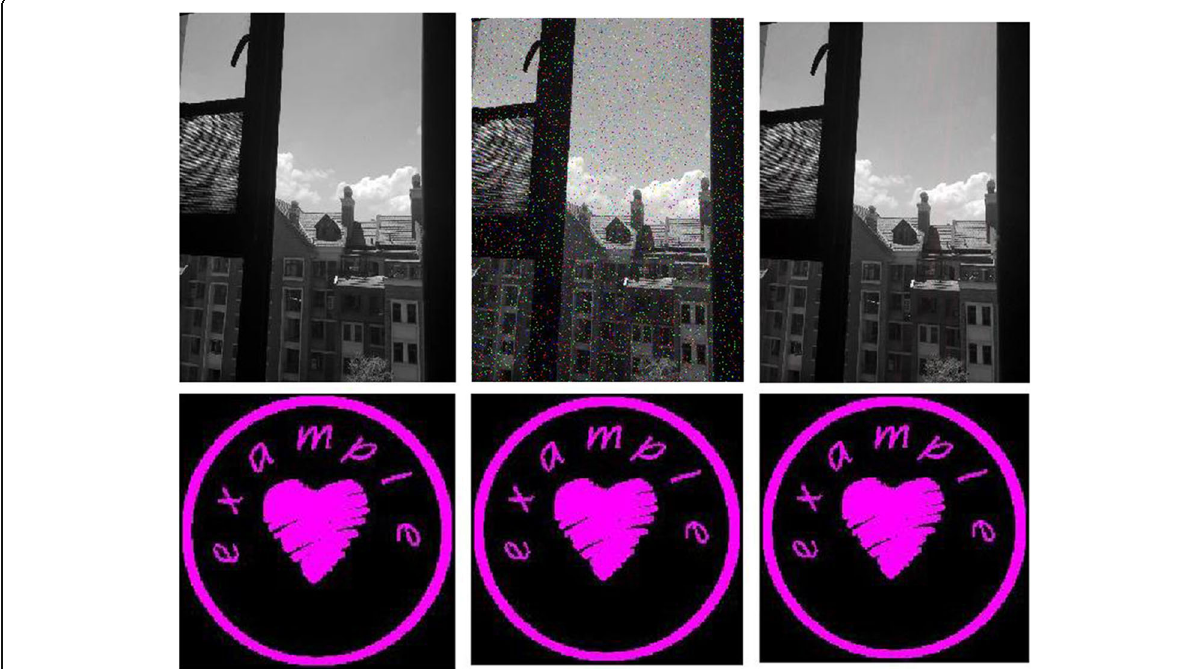
Fig. 2 Comparison of digital watermark before and after. (The first row from left to right are the original image, plus noise and watermark, and the noise is removed; the second row are the watermark original, the watermark extracted from the noise plus watermark, and the watermark extracted after